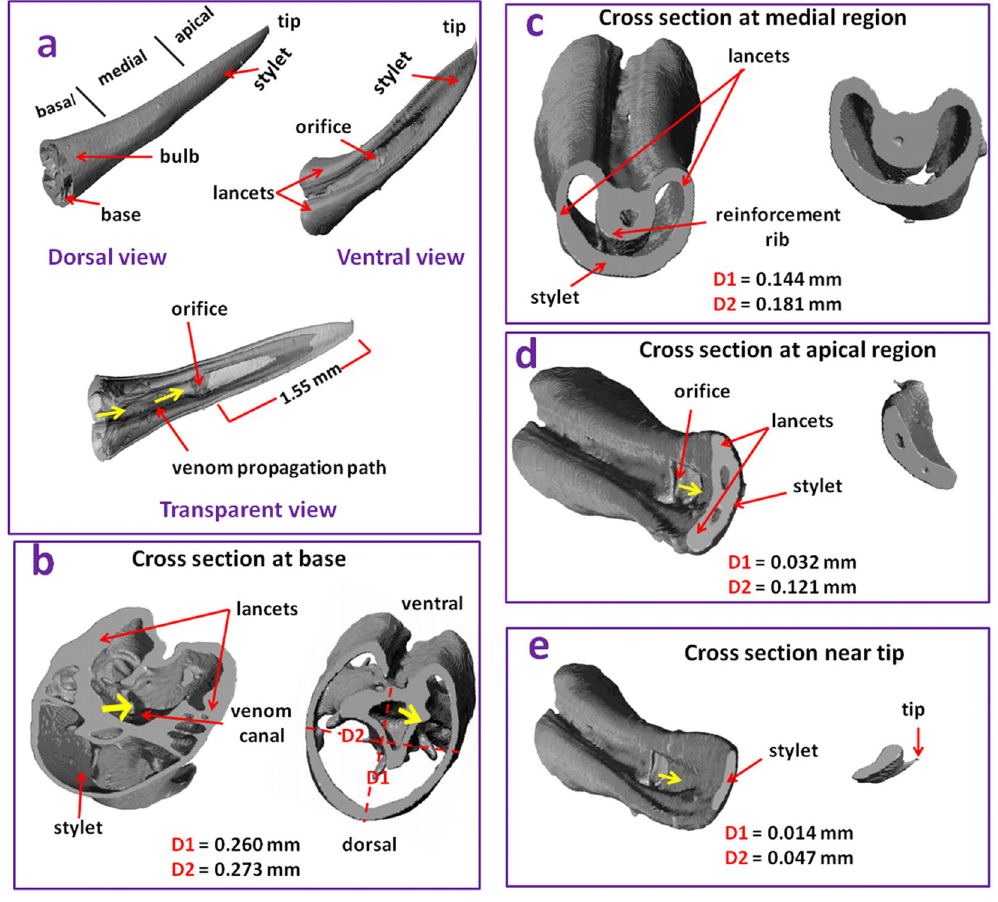
Figure 1. ( a) Structure of whole wasp stinger obtained from micro-CT ( b ) Cross section at the base ( c ) Cross section at the medial region ( d ) Cross section at the apical region, and ( e ) Cross section near the tip. It is observed that the stylet and lancets have hollow shaft and their radii decrease from the base to tip. The hollow structures diminish near the apical region and are transformed into solid structures. The cylindrical hollow venom propagation path is also